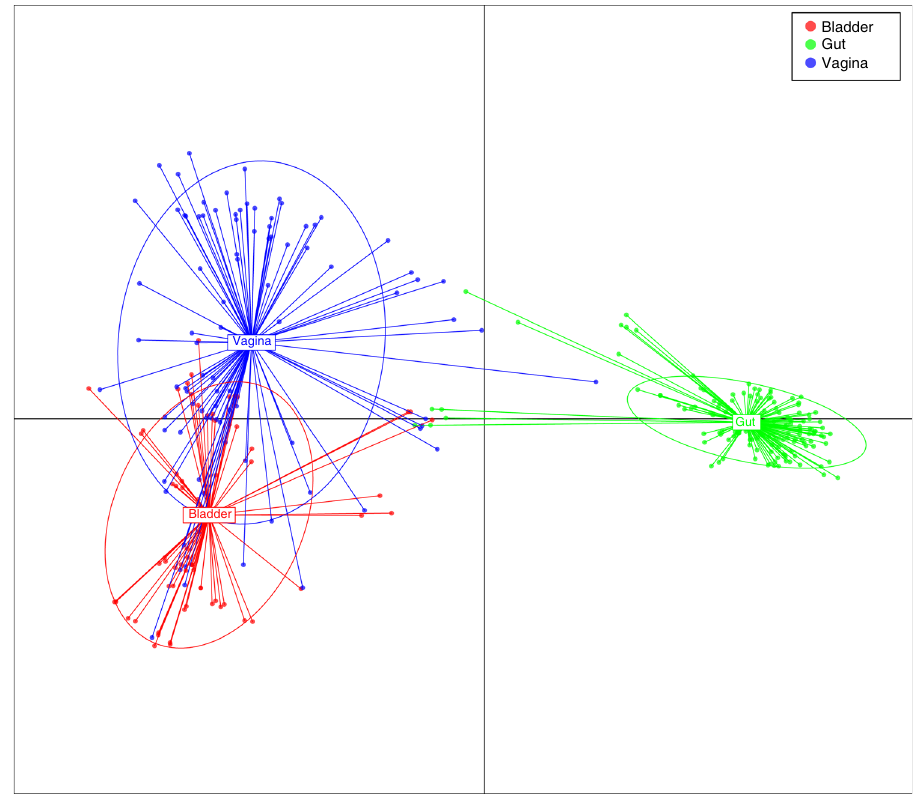
Fig. 2 Functional diversity between genomes of bacterial strains isolated from the bladder, vagina, and intestine. Discriminant analysis of principal components using conserved protein domains (CDD). Each color dot represents a strain from 3 different niches: blue (vagina; n = 92), red (bladder; n = 67), and green (gut; n =